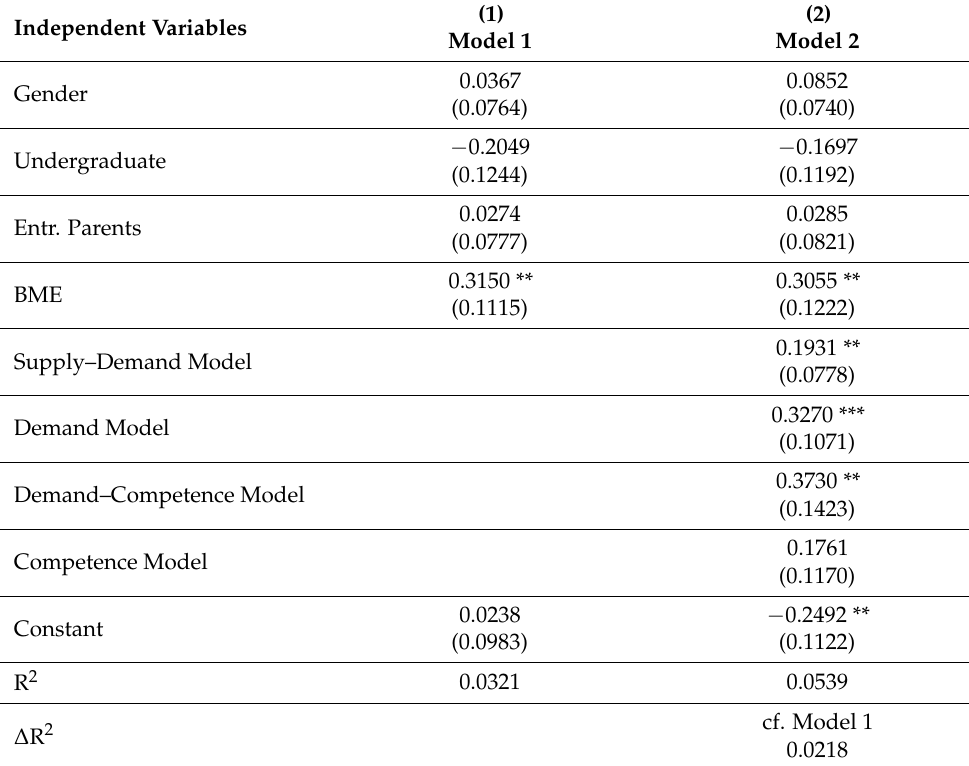
Table 9. Main regression